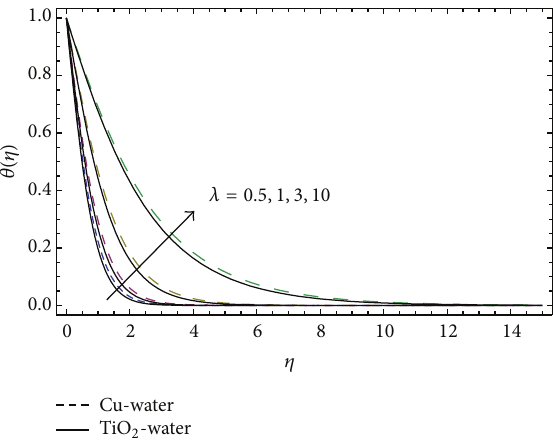
Figure 6: Effect of 𝜆 on the velocity distribution 𝑓 󸀠 (𝜂) for the Cu- water and the TiO 2 -water nanofluids at Pr = 6.2 , 𝑀 = 1 , and 𝜙 = 0.1 .